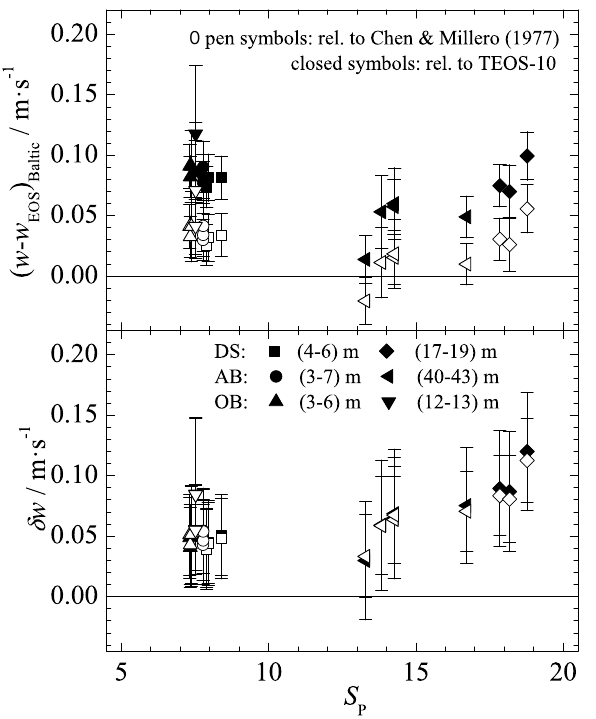
Figure 5. Upper panel: measured speed of sound (Baltic) rela- tive to calculated values with equations of TEOS-10 and Chen and Millero (1977) for the same ( S P , T , p ). The displacement between both reflects differences in the outputs of the equations. Lower panel: speed-of-sound anomaly δw = (w − w EOS ) Baltic, in situ – ( w – w EOS ) Atlantic, ref (upper panel “minus” Fig. 4).